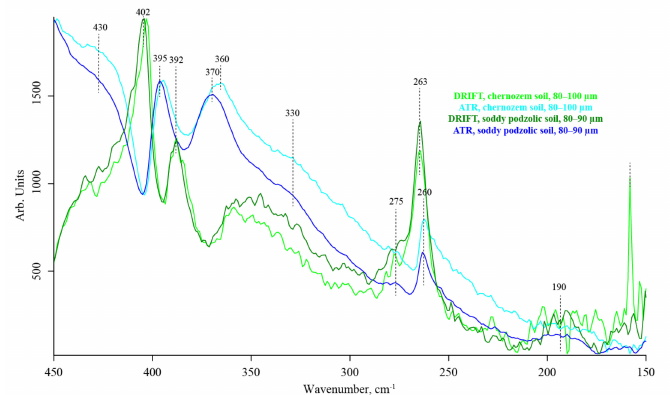
Figure 11. Normalized FTIR spectra in 1170–800 cm − 1 . DRIFT and ATR spectra of shelterbelt chernozem soil (dry fractionation, 80–100 µ m), light green and light blue, respectively; and DRIFT and ATR spectra of sod-podzolic soil (dry fractionation, 80–90 µ m), dark green and dark blue,